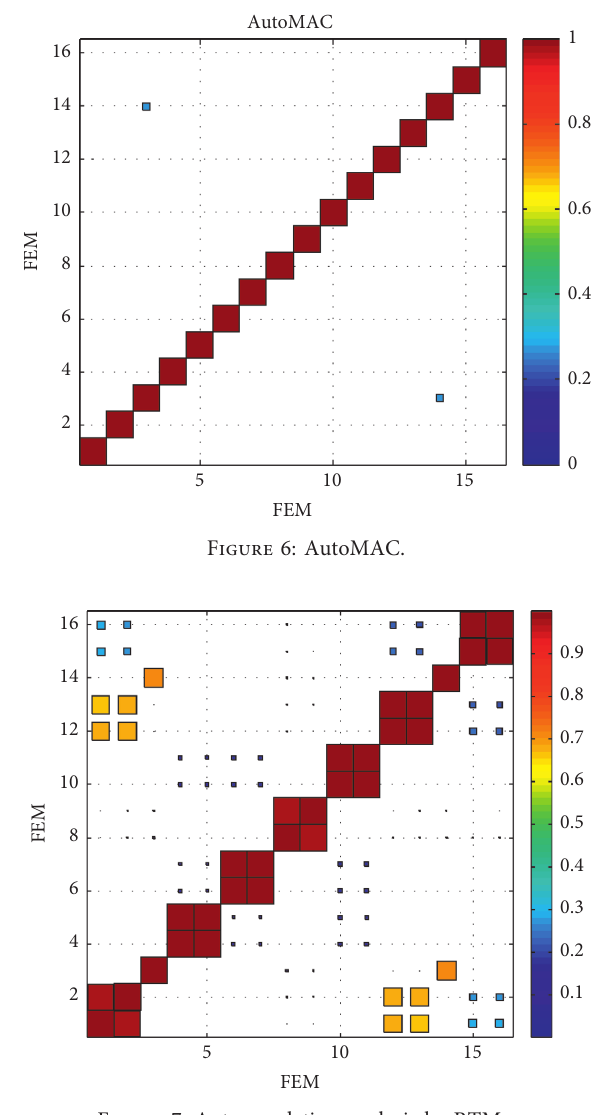
Figure 7: Autocorrelation analysis by